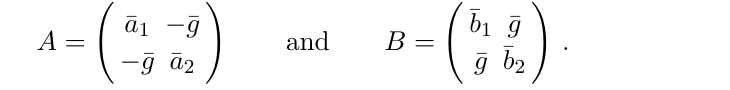
Figure 9 . The relative di(cid:11)erence between the mode-by-mode physical-basis ‘complexity’ ~ C phys the optimal physical-basis complexity C phys